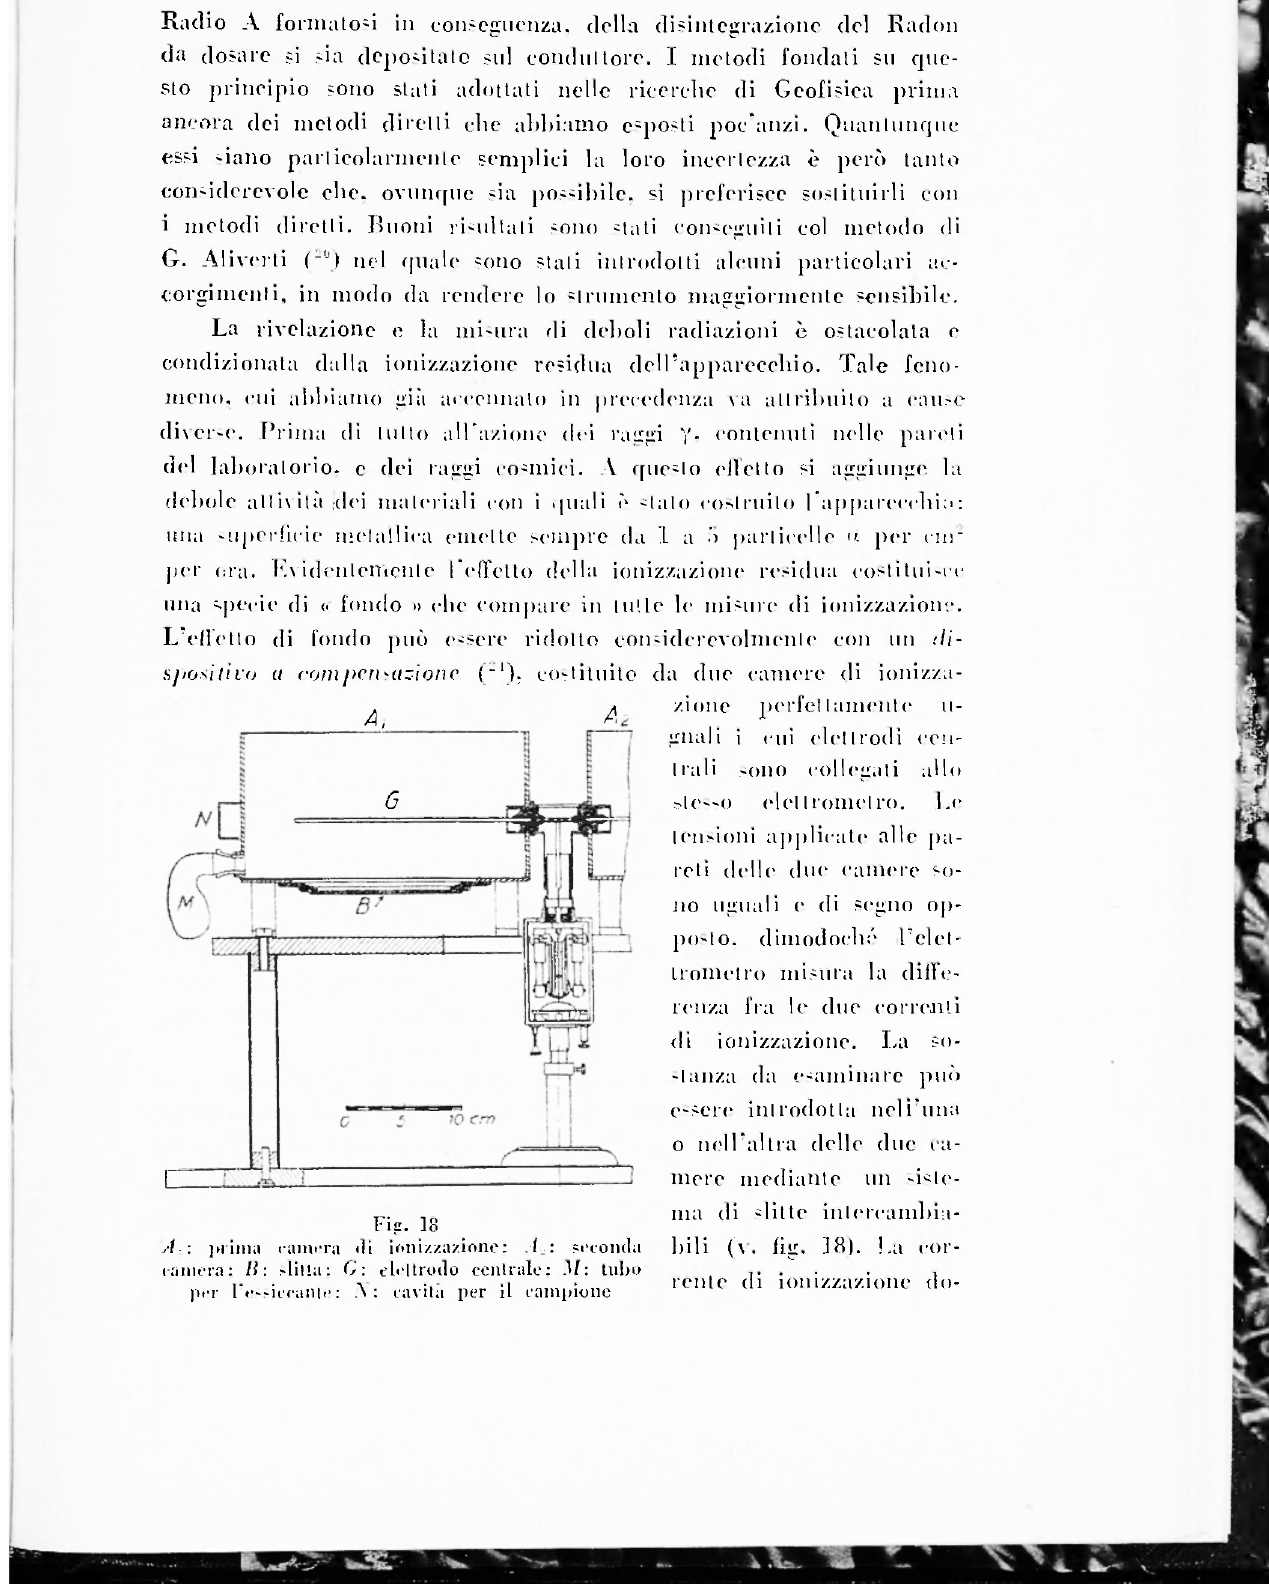
Fig. 18 A : prillili camera ili ionizzazione: A :